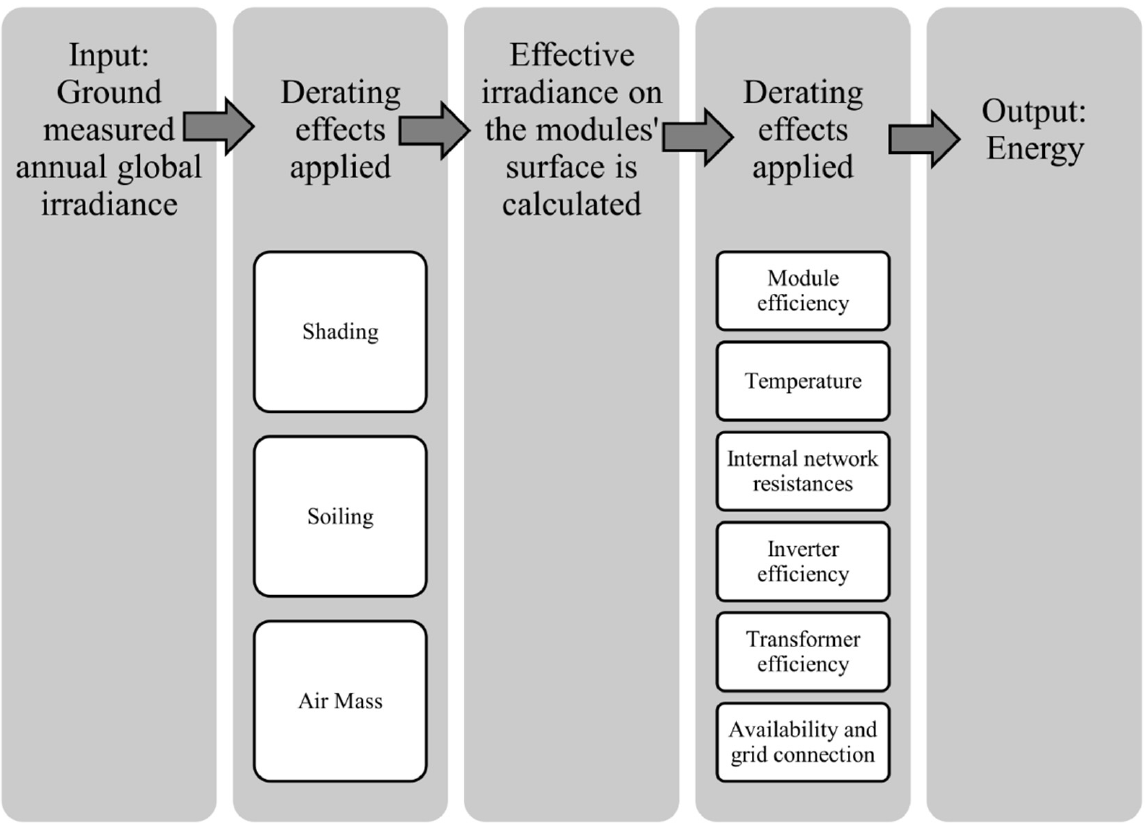
Figure 1. Process map showing a typical PV model with the input, processes and output.